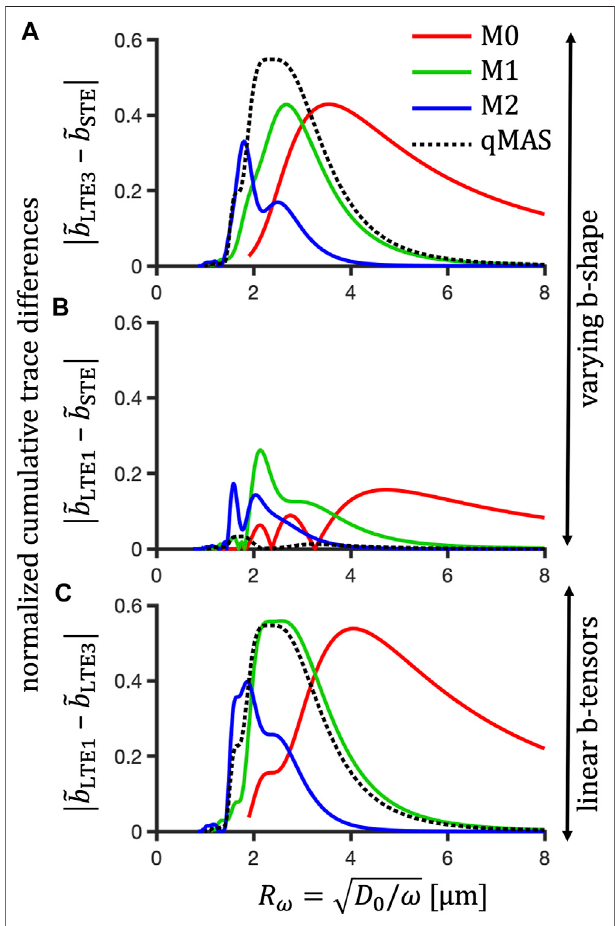
FIGURE 7 | Differential size sensitivity for different degrees of motion compensation. Absolute differences in normalized cumulative encoding powerbetweenSTEandLTE3 (A) ,STEandLTE1 (B) ,andbetweenLTE3and LTE1 for the preclinical M0 (red), M1 (green) and M2 (blue) waveforms. As a reference, a comparison between the “ detuned ” LTE and STE, “ tuned ” LTE and STE and between “ tuned ” and “ detuned ” LTE are shown for qMAS (black doted lines) in panels A, B and C, respectively. The x -axis shows the “ relative detection size ” R ω for D μ m 2 /ms. Note that the maxima shift to 0 = 2.5 smaller sizes (higher frequencies) from M0 to M2. The relatively high values for qMAS in panel A indicate poor tuning, while the low values in panel B indicate good tuning between STE and LTE waveforms. The differential sensitivity for qMAS is similar to that of the M1 waveforms, which is particularly visible in panels A and C. Large values in panel C are indicative of large spectral anisotropy for the preclinical STE. Note that the differential sensitivity tends to generally decrease with the degree of motion compensation, which is characterized by increasing power at higher